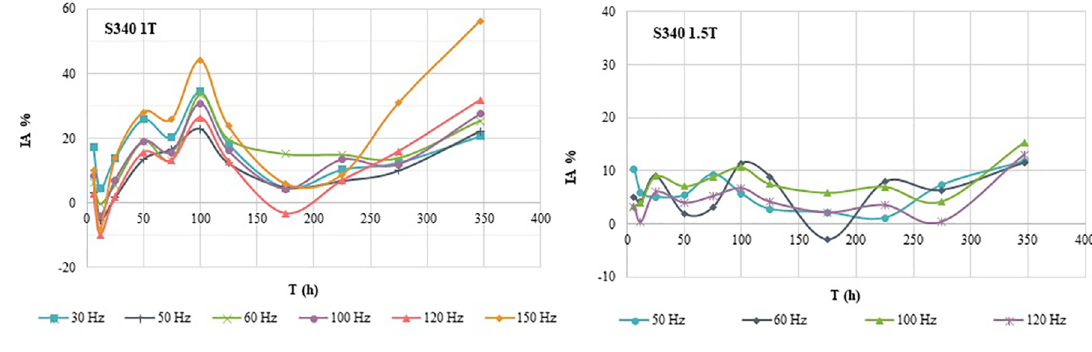
Figure 6. Anomalous losses from different aging time against the excitation frequency, for steel S340.